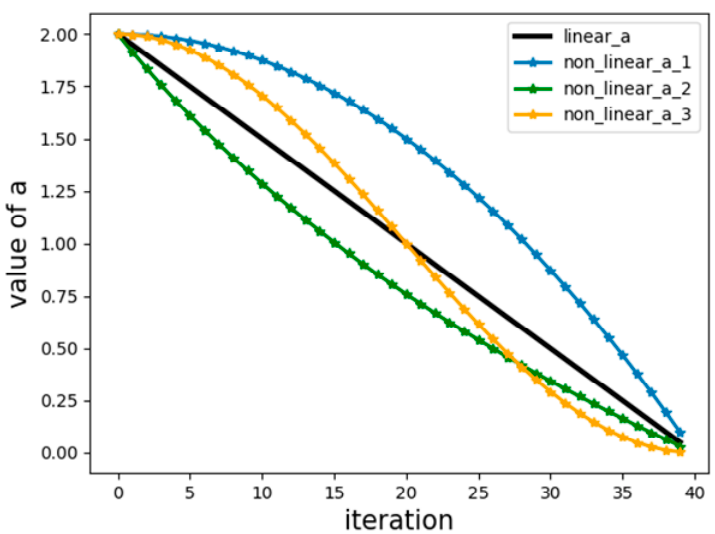
Figure 5. Comparison of decay curves of decay functions with different convergence factors: “lin- ear_a” represents the convergence factor of linear decay; “non_linear_a_1” represents the convergence factor of gradual faster decay; “non_linear_a_2” represents the convergence factor of gradual slower decay, and “non_linear_a_3” represents the decay function of improved convergence factor .